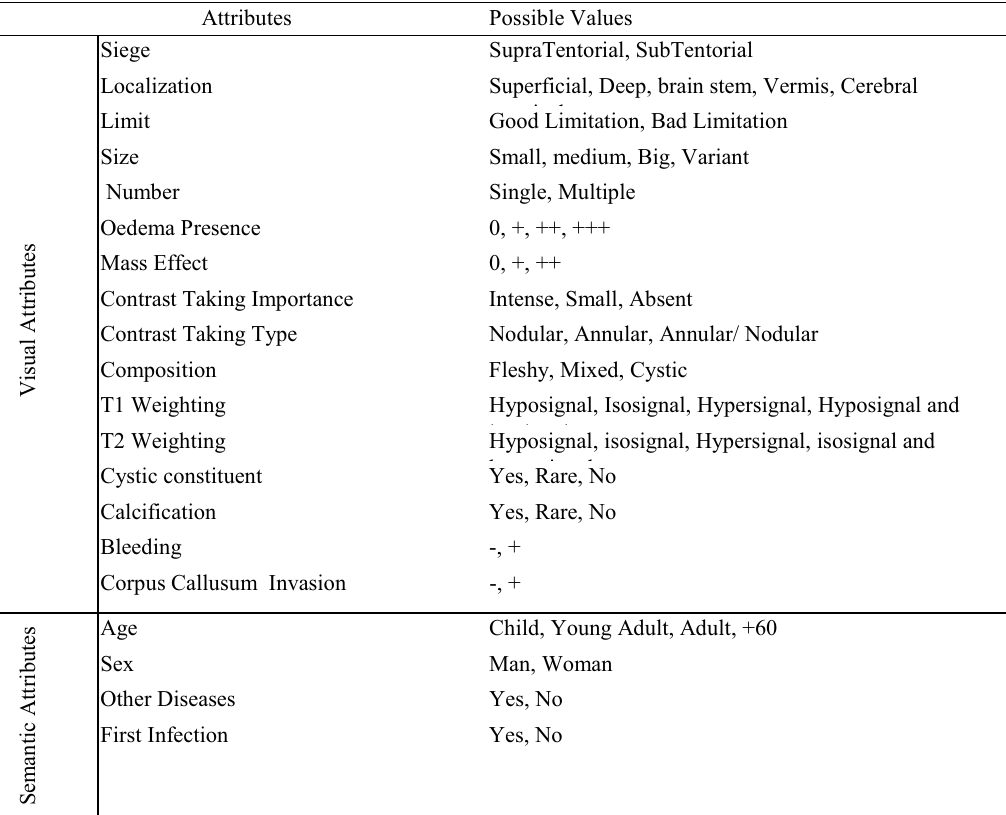
Table 2. Attributes referring List of MRI case